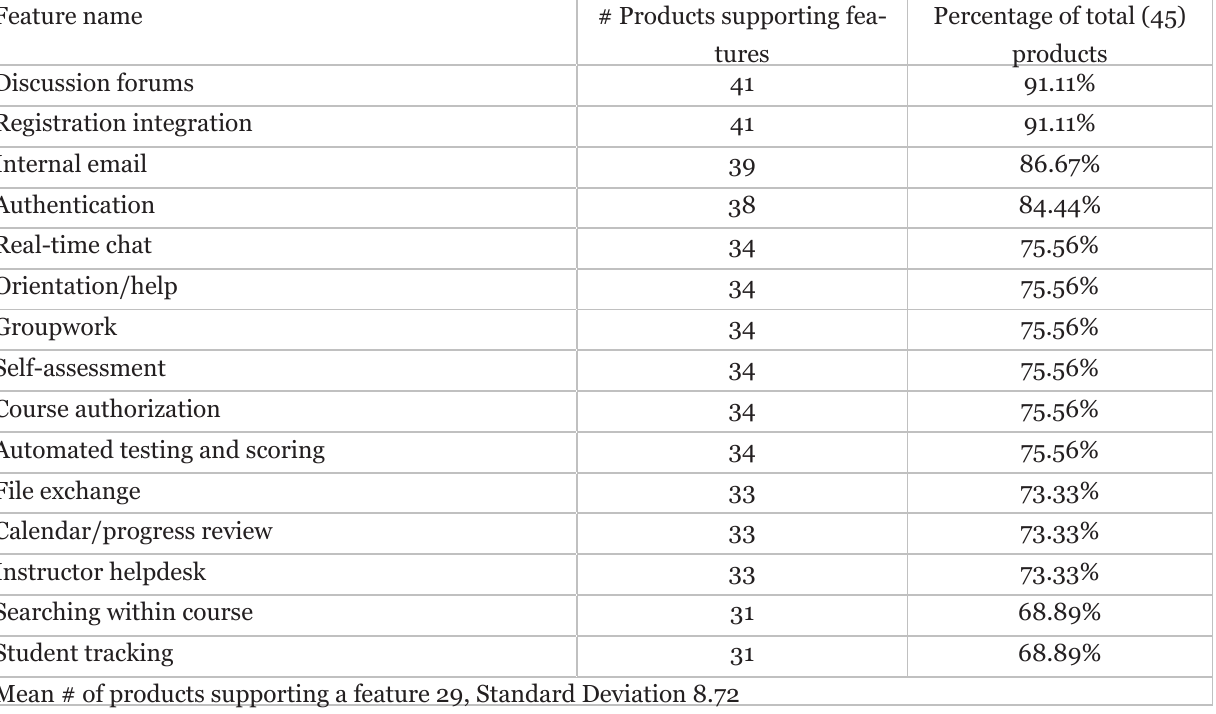
Top 15 Features Supported across